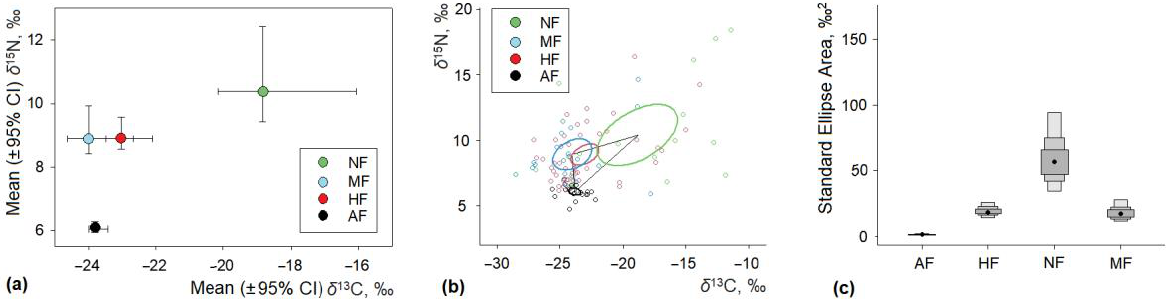
Figure 3. Position of M. musculus in isotopic space according to hair sample stable isotope ratios in the gradient of available food sources ( a ), ellipses, representing isotopic niche width areas of the mice, according to available food sources ( b ), and SEA density plots, representing the credibility intervals of the Bayesian SEA with shaded boxes encompassing the 50th, 75th and 95th (shown from dark to light) credibility intervals, according to available food sources ( c ). NF—mice foods originated from natural sources, MF—mice foods from natural and anthropogenic sources; HF—human foods available; AF—livestock, rabbits and poultry feed available.